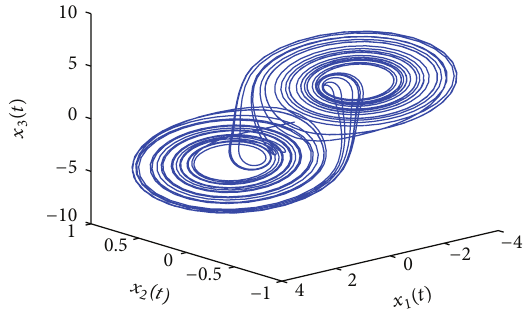
Figure 7: Chaotic orbits of Chua’s circuit.